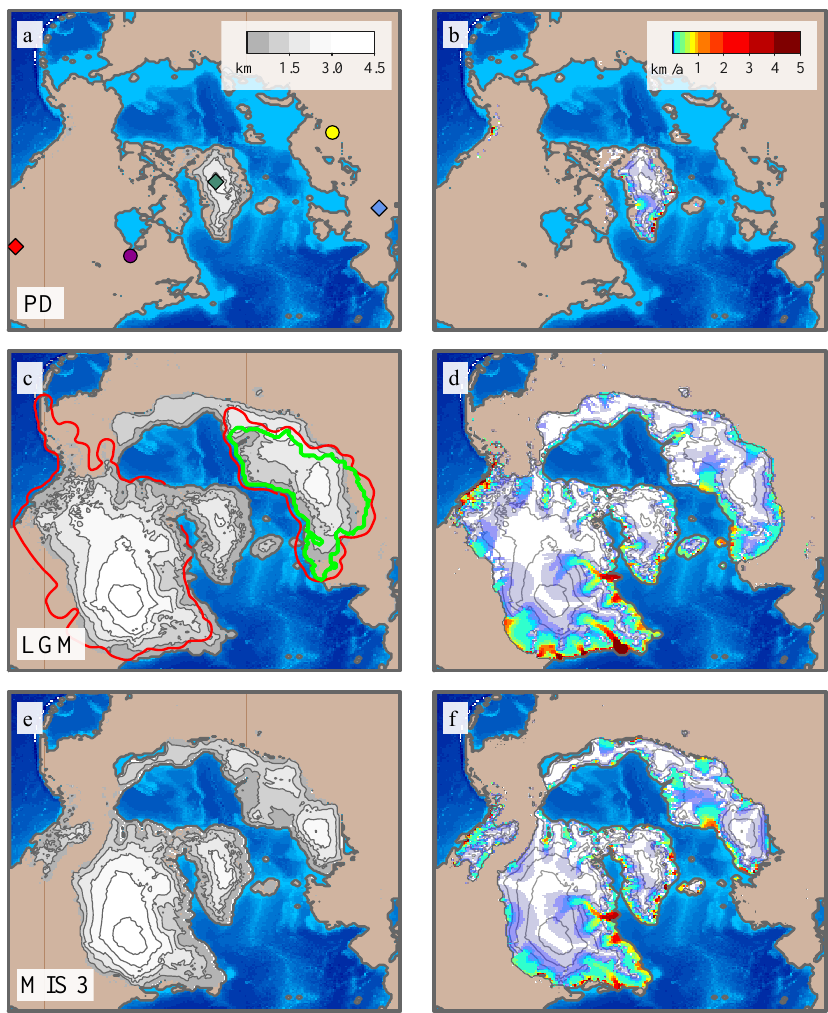
Figure 4. NH ice-sheet configurations at different stages of the last glacial–interglacial period as simulated under M3: (a) present-day ice thickness (km) and (b) present-day ice velocities (kma − 1 ). Panels (c,d) and (e,f) show the same information as (a,b) for the LGM and MIS3 stages, respectively. Red and green contours in panel (c) represent the ICE-5G (Peltier, 2004) and DATED-1 (Hughes et al., 2016) extent of NH ice sheets at the LGM (Peltier, 2004). Colored diamonds (proxy-based information) in panel (a) show the approximate locations of the NGRIP site (light green), Fort Stanton Cave (red) and northern Alps (NALPS) stalagmites. (light blue). Colored dots (proxy-based reconstructions unavailable) show the locations of the two central sites considered at the LIS (purple) and the FIS